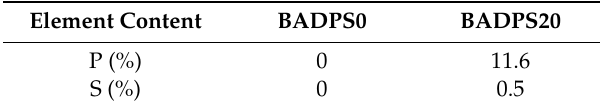
Table 3. P and S element analysis of the char residues for UPRs. Table 4. P and S element analysis of the char residues for UPRs.